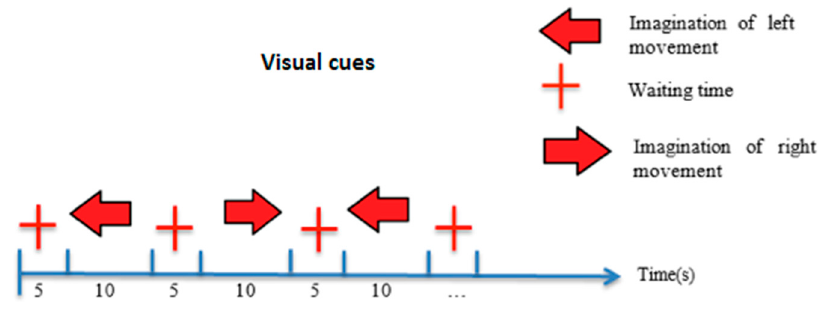
Figure 3. Visual cues with timing scheme.